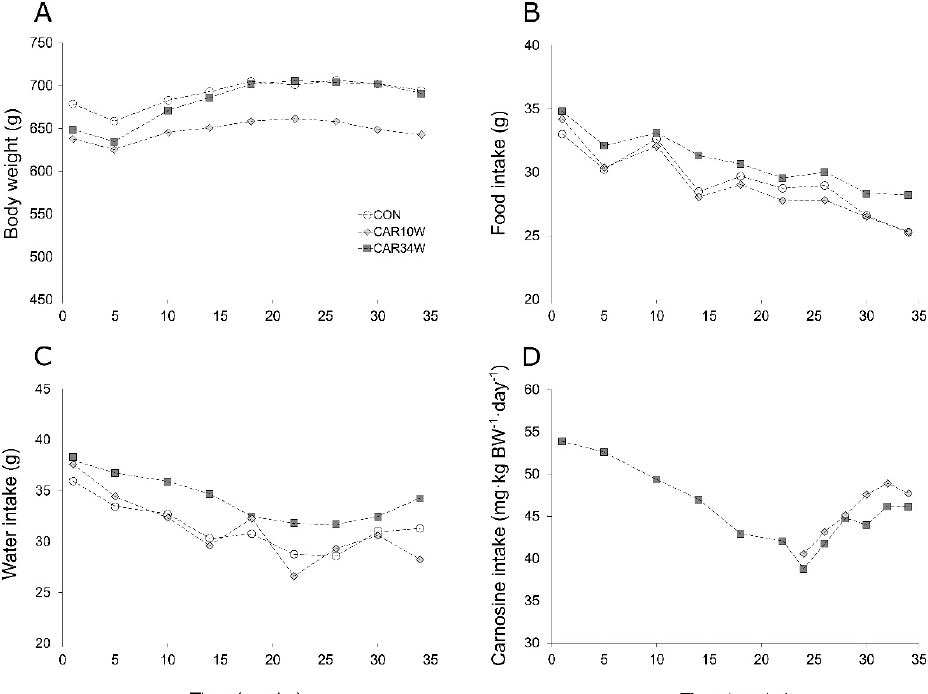
Figure 5. The mean values of body weight ( A ), as well as of food ( B ), water ( C ), and carnosine daily intake ( D ) in the three groups of animals, measured weekly throughout the whole study period.